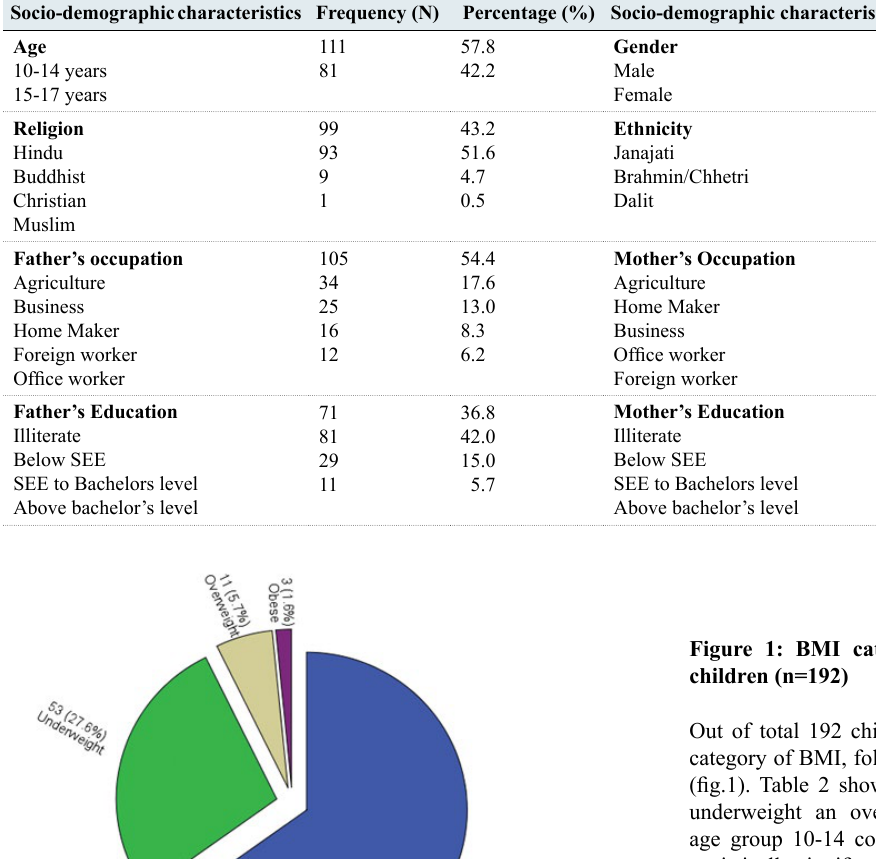
Table1: Socio-Demographic Characteristics of Adolescent School Going Children (N=192) Socio-demographic characteristics Frequency (N) Percentage (%) Socio-demographic characteristics Frequency (N)